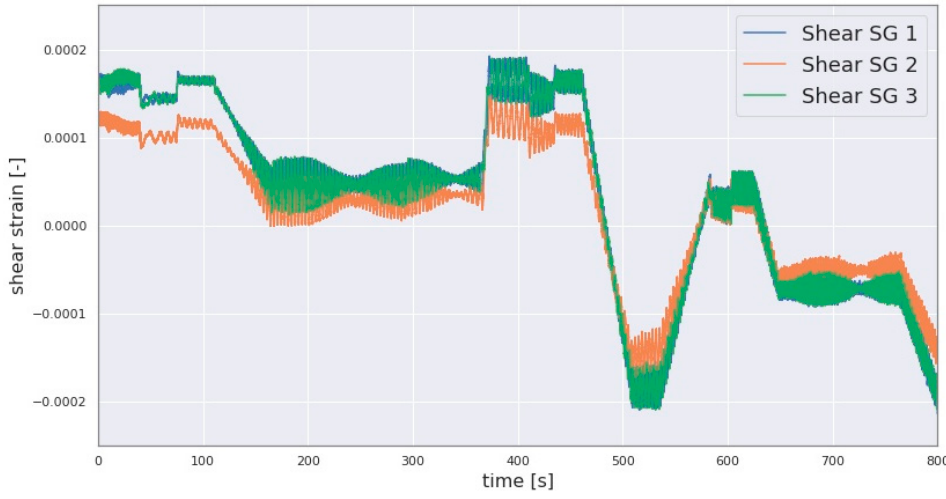
Figure 5. Three shear strain signals including the deviation between the signals.